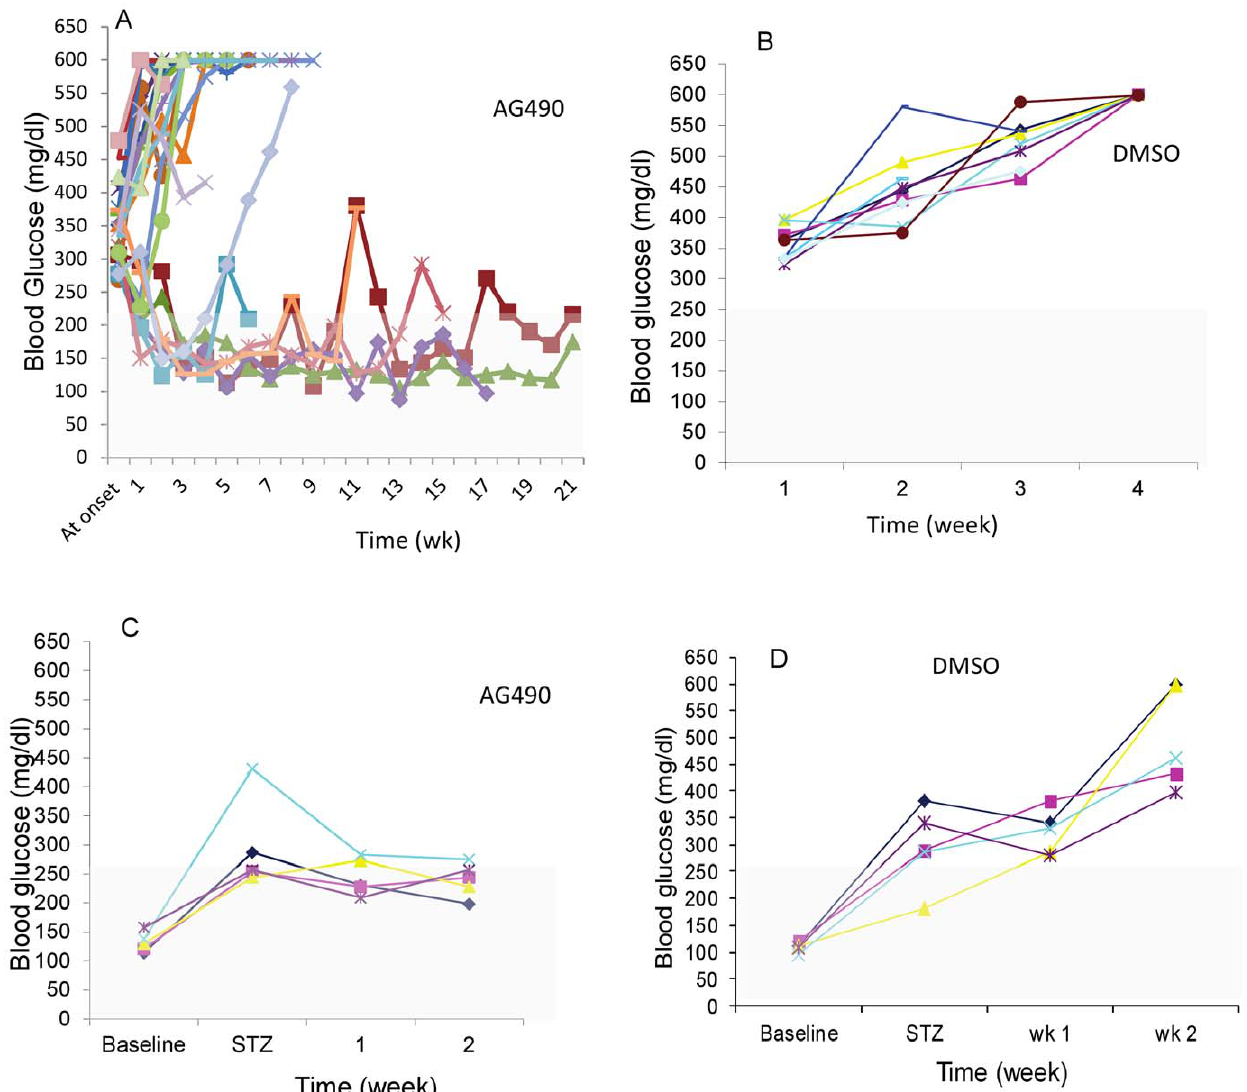
Figure 2. AG490 induces remission of diabetes in NOD and in STZ-induced diabetic mice. Newly diagnosed and established diabetic NOD mice were treated with AG490 (i.p, 1 mg/mouse) without insulin supplement (A) (n=23) or with DMSO (B) (n=10). Blood glucose was measured by ACCU-CHECK 2–3 times weekly. Sustainable euglycemia was observed for several months after drug withdrawal while DMSO treated mice expired within 2–4 week after disease onset. The average blood glucose at the disease onset in the cured NOD mice was 314.43 mg/d (Max=374; Min=277 mg/dl) versus 384.58 mg/dl (Max=478, Min=335 mg/dl) in mice that AG490 failed to restore euglycemia (p , 0.0014). An average blood glucose in cured NOD mice treated with AG490 was 169.82 mg/dl 6 23.21, n=7 versus 555.13 6 63.79, n=17 in uncured NOD mice (p=1.15E-11). (C) Diabetes was induced by STZ injection in male BALB/c mice and one week after the last injection diabetic mice were treated with either AG490 or DMSO (D) (n=5/group). The blood glucose level was significantly lower (p , 0.004) in AG490 treated mice when compared with DMSO treated mice. [This figure is intended to be in color online and black and white in print.]